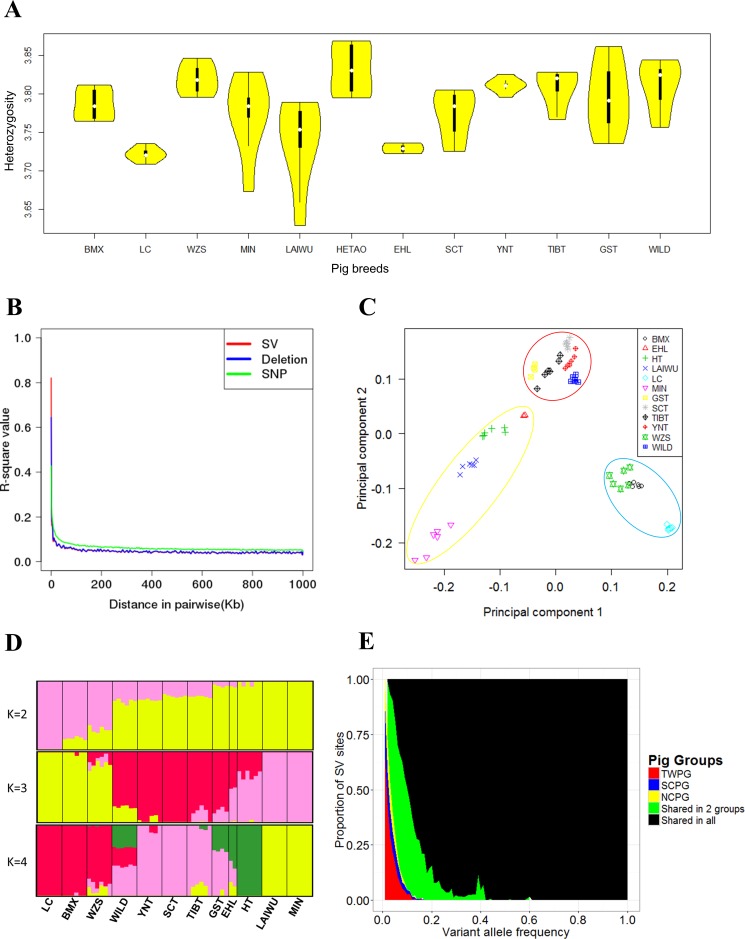
Population genetic properties in distinct regions of Chinese pigs.BMX, Bamaxiang; EHL, Erhualian; HT, Hetao; LAIWU, Laiwu; LC, Luchuan; MIN, Min; GST, Tibetan (Gansu); SCT, Tibetan (Sichuan); TIBT, Tibetan (Tibet); YNT, Tibetan (Yunnan); WZS, Wuzhishan; WILD, Southern Chinese wild boar. (A) Log10 values of deletions heterozytosity of all pig breeds. (B) The LD decay of SVs, deletions, and SNPs. (C) Principal component analysis based on deletions of 66 Chinese pigs. Yellow, red, and blue circles stand for NCPG, TWPG, and SCPG, respectively. (D) Admixture analysis of deletions in Chinese pigs (K = 2, 3, and 4). (E) Frequency distribution of SVs in different groups of Chinese pigs, in which the red, blue, and yellow bars stand for specific SVs in TWPG, SCPG, and NCPG, respectively. The green bars represent SVs shared by any two groups of Chinese pigs, and black bars denote SVs shared by all three groups.